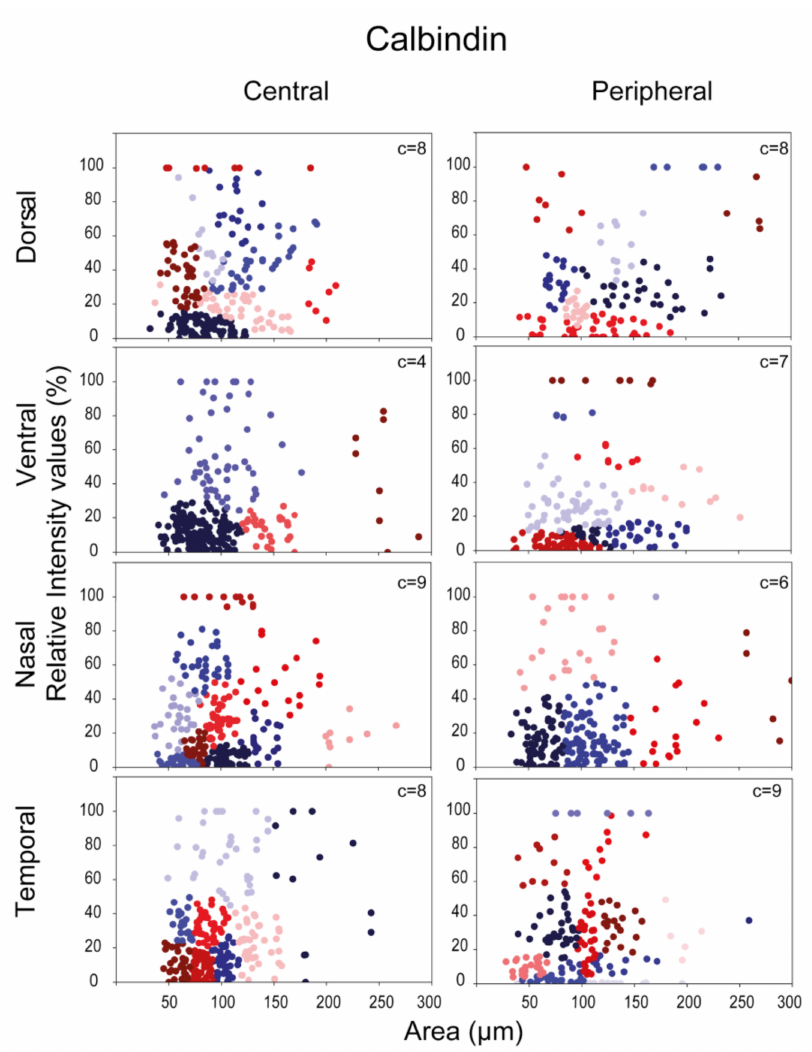
Figure 4. Cluster analysis of CaB expressing RGCs. Two features (RGC soma size and CaB expression level) were utilized to perform the clustering in both central (left) and peripheral (right) retinal areas in each quadrant. Dots indicate individual cells from n = 8 retinas. The clusters of RGCs are color-coded (note that colors do not necessarily represent the same cluster in separate panels). The number of clusters are shown in the top right corner of each